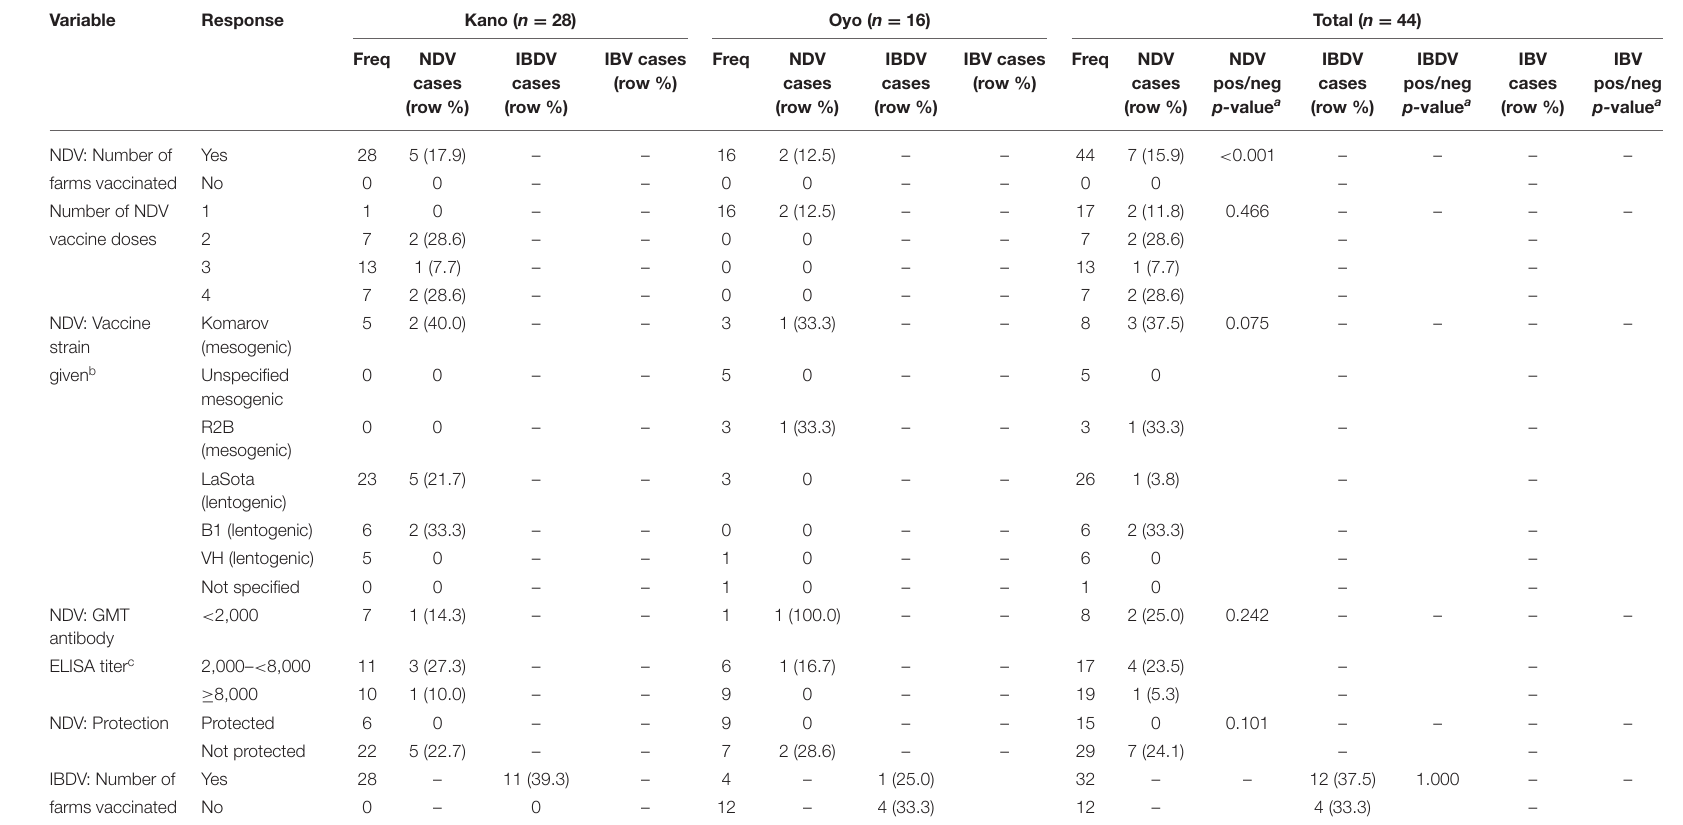
TABLE 2 | Descriptive analysis of study flocks, evaluating associations between select flock vaccination variables and cases of NDV, IBDV, and IBV as determined by